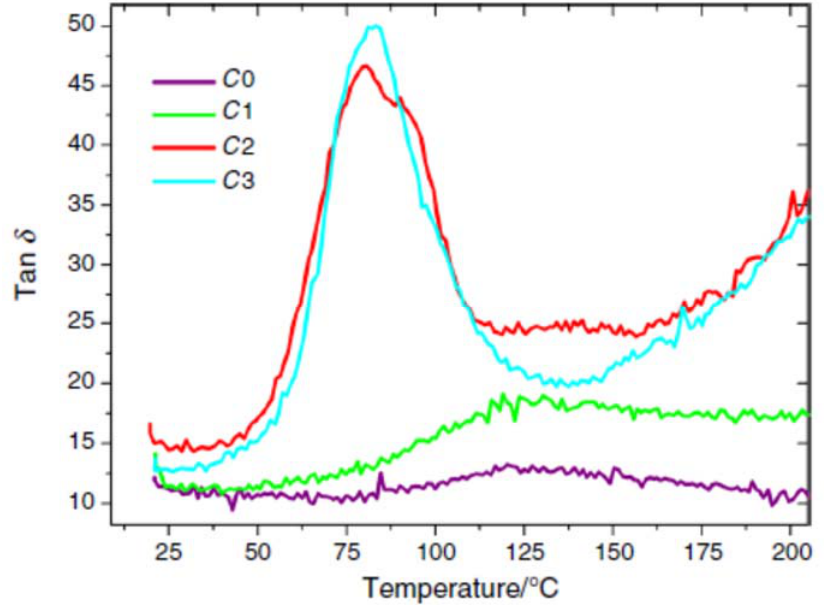
DMA curves of (C0) geopolymer with pure metakaolin; (C1) geopolymer with metakaolin/fly ash at 20%; (C2) geopolymer with metakaolin/fly ash at 50%; (C3) geopolymer with metakaolin/fly ash at 70%. Reprinted from [34] with permission of Springer Nature.